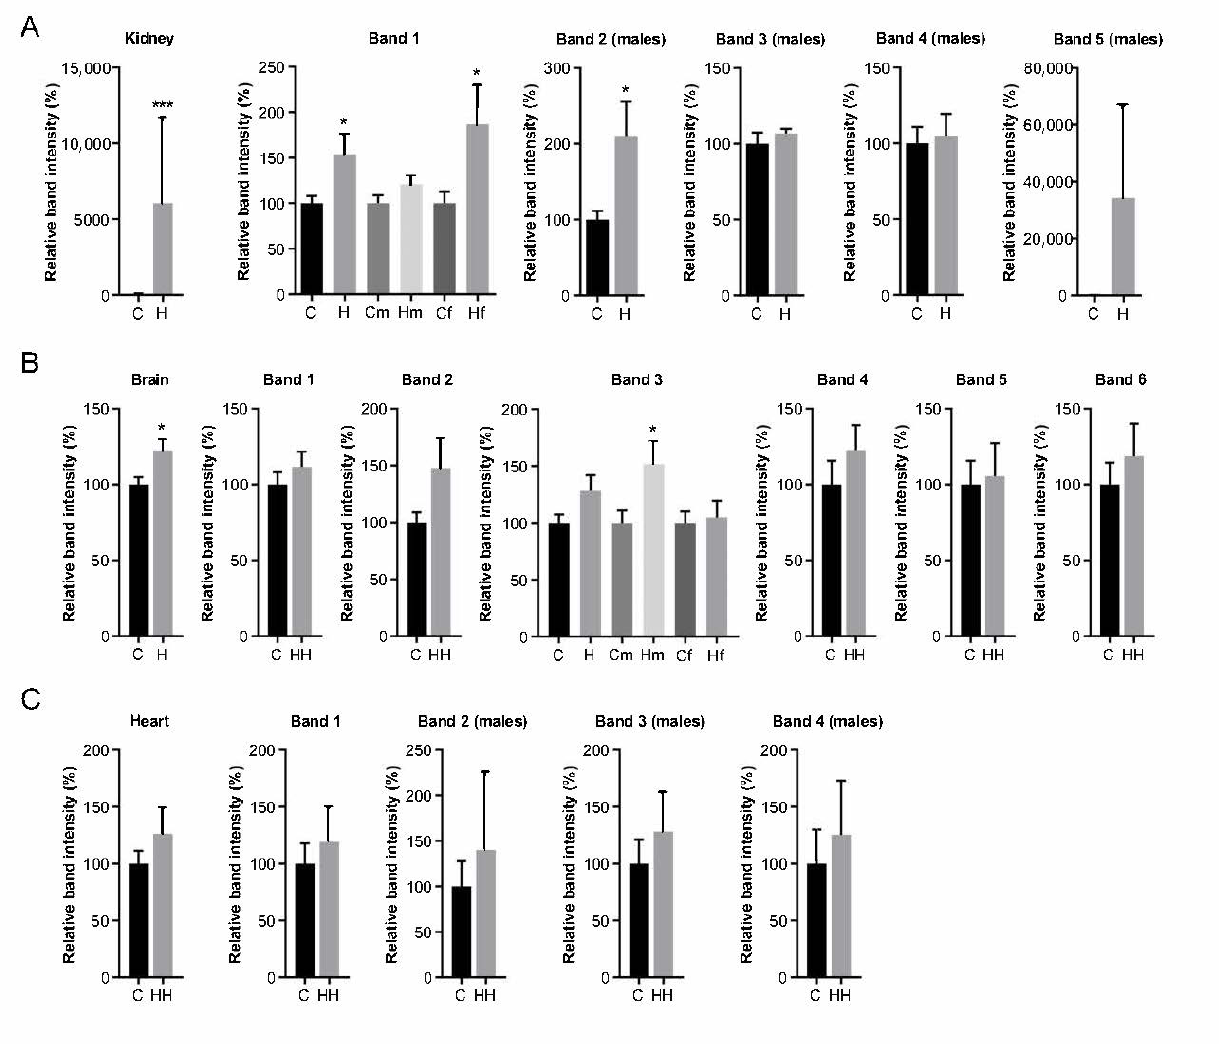
Figure 4. Densitometric analyses of 4-hydroxynonenal (HNE)-protein signals. Global and individual intensities of bands as shown in Figure 3A and identified in Table 2 from ( A ) kidney, ( B ) brain and ( C ) heart of control (C) and Hfe − / − (H) mice. Analysis of male (m) and female (f) mice is shown separately only in cases of statistically significant results. When band analysis is shown for males only, it is indicated in brackets (males) at the top. Total Hfe − / − mice or control n = 18; male/female Hfe − / − or control mice n = 9. Values are expressed as relative band intensity (%) considering 100% the mean value of n = 18 control mice or n = 9 male/female control mice as indicated (mean ± SEM). Statistical comparisons were performed between groups using Student unpaired t -tests or Mann–Whitney U-tests. * p < 0.05, *** p ≤